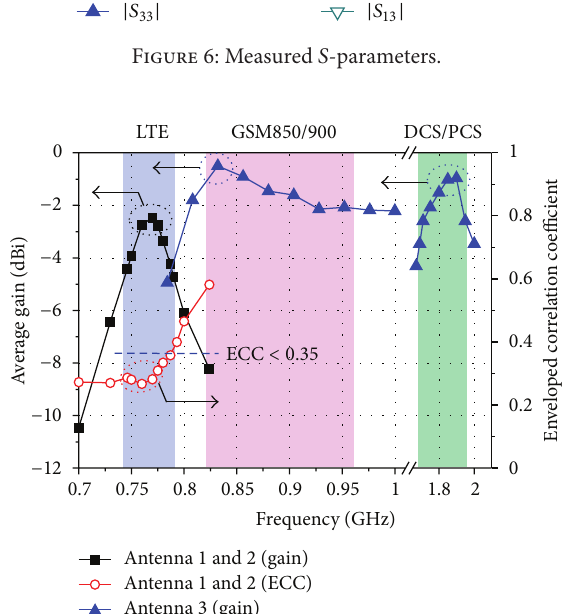
Figure 7: Measured average gain and ECC.